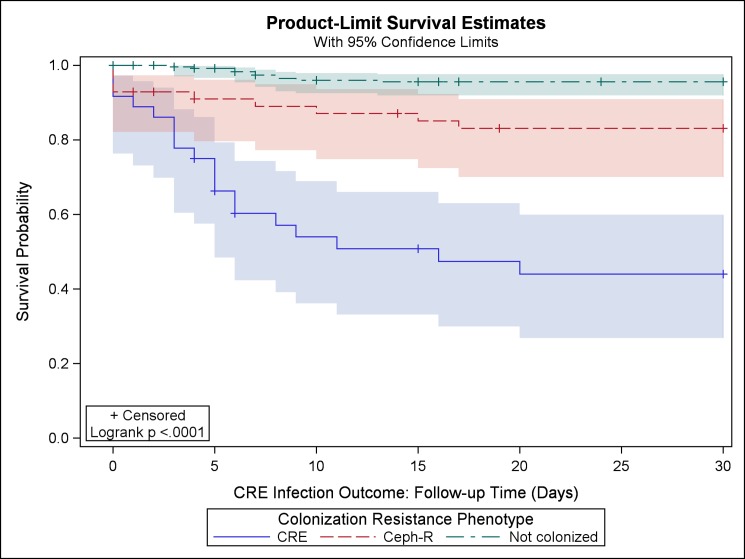
Kaplan-Meier estimates (and 95% confidence limits) of the probability of remaining uninfected with CRE, 30 day follow up.